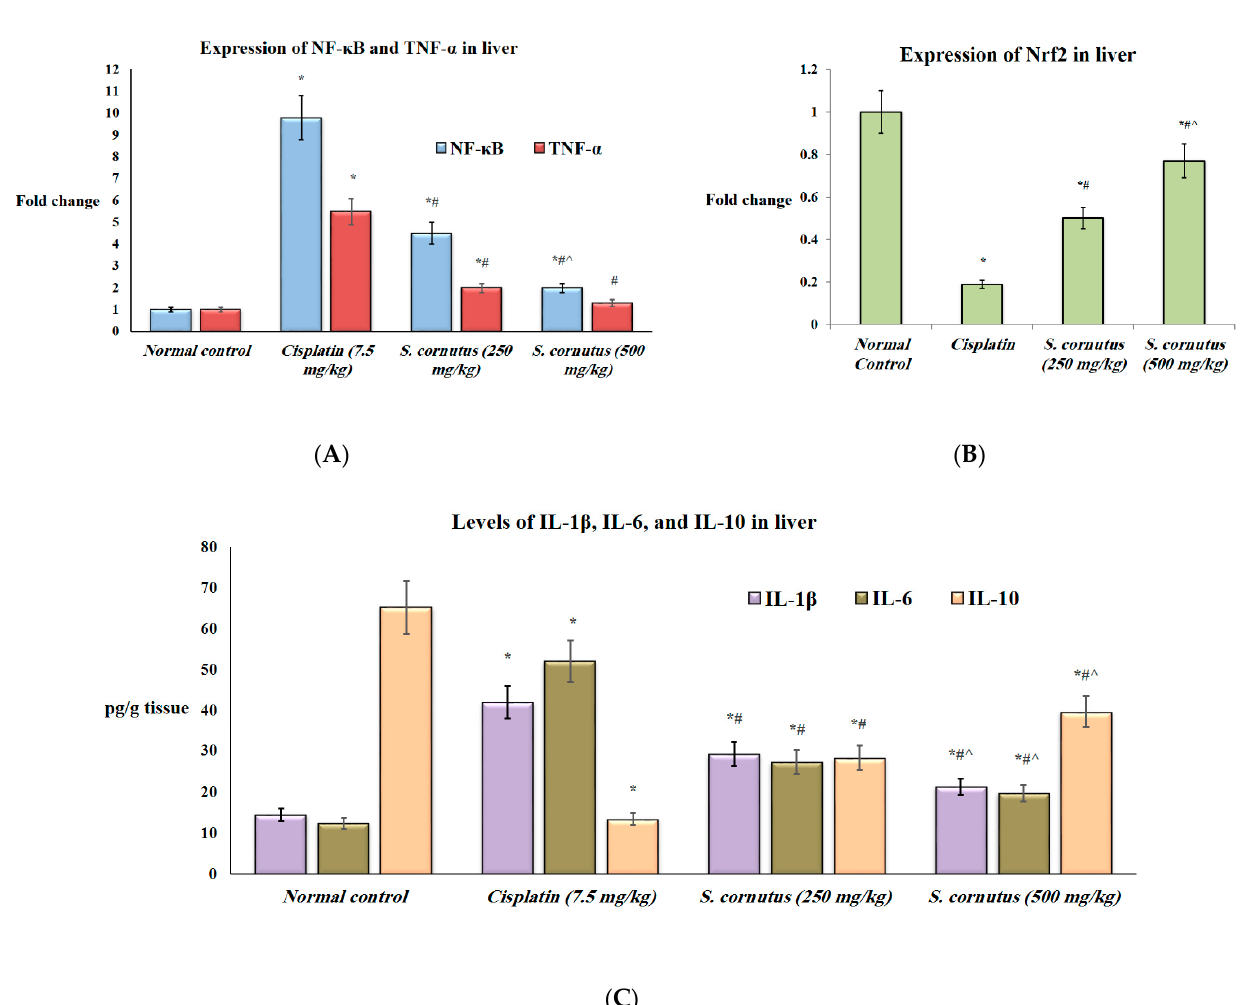
Figure 2. The effect of S. cornutus crude extract on the expression and protein levels of inflammtory markers in the liver tissue of the experimental mice. ( A ) NF- κβ and TNF- α expression, ( B ) Nrf2 expression, ( C ) Il-1 β , IL-6, and IL-10 levels. NF- κβ = nuclear factor kappa B; TNF- α = tumor necrosis factor- α ; Nrf2 = nuclear factor-erythroid factor 2-related factor 2; IL = interleukin. Data are expressed as mean ± SD and analyzed using one-way ANOVA followed by Bonferroni’s post hoc test ( n = 8). * significantly different vs. the normal control group; # significantly different vs. the cisplatin group; ^ significantly different vs. the S. cornutus (250 mg/kg) group. Differences were considered significant at p < 0.05.